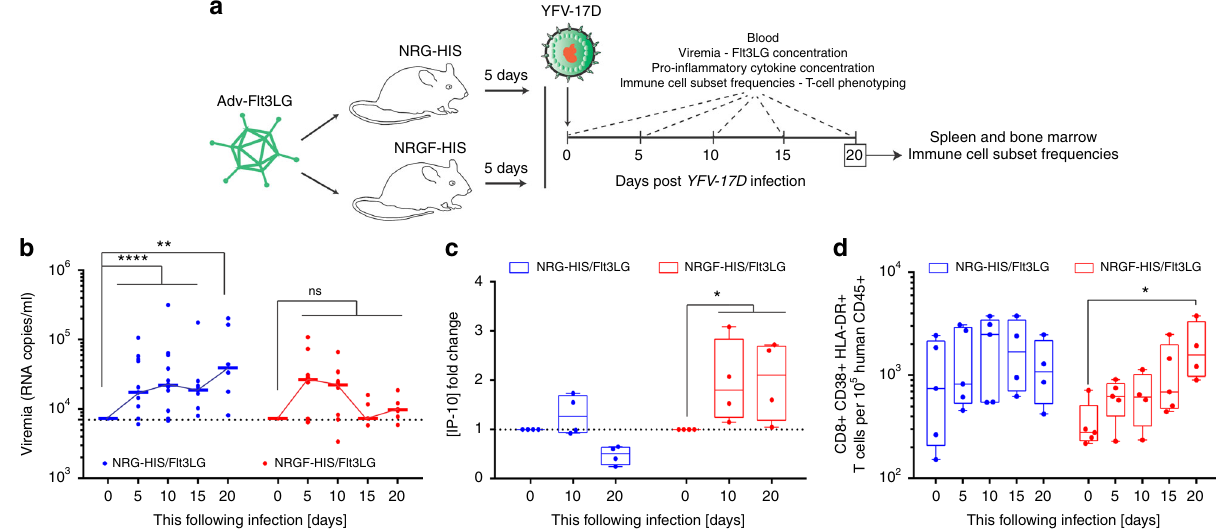
Fig. 6 Improved control of infection and T-cell activation in NRGF-HIS/Flt3LG mice. a Schematic representation of the NRG-HIS and NRGF-HIS mice time course infection experiment. b YFV-17D serum viremia in the peripheral blood of NRG-HIS (blue, n = 12) and NRGF-HIS (red, n = 8) mice over the course of infection. ( + ) RNA copies per ml were quanti fi ed by RT-qPCR. Limit of detection (dotted line) is shown. Horizontal lines represent median viremia at each time point. ** p ≤ 0.01, **** p ≤ 0.0001, ns non-signi fi cant (Wilcoxon – Mann – Whitney test). c IP-10 concentration fold-change in the serum of NRG-HIS (blue) and NRGF-HIS (red) mice over the course of infection. Bounds of box and whiskers represent the min-to-max concentration of IP-10 at each time point. Medians are indicated in each box as center line ( n = 4 – 5 per group). * p ≤ 0.05, *** p ≤ 0.001, ns non-signi fi cant (Wilcoxon – Mann – Whitney test). d Frequencies of human CD3 + CD8 + HLA-DR + CD38 + T cells in the blood of NRG-HIS (blue) and NRGF-HIS (red) mice over the course of YFV-17D infection. Bounds of box and whiskers represent the min-to-max frequencies of CD8 + HLA-DR + CD38 + T cell at each time point. Medians are indicated in each box as center line ( n = 5 per group). * p ≤ 0.05 (two-way